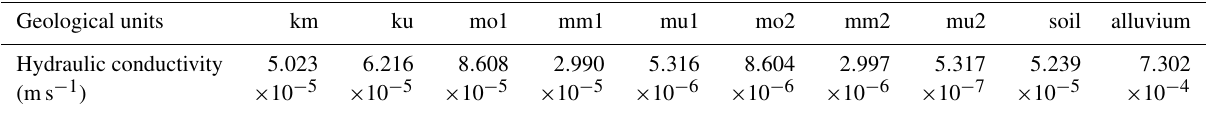
Table 2. Hydraulic properties used in the uniform recharge scenario